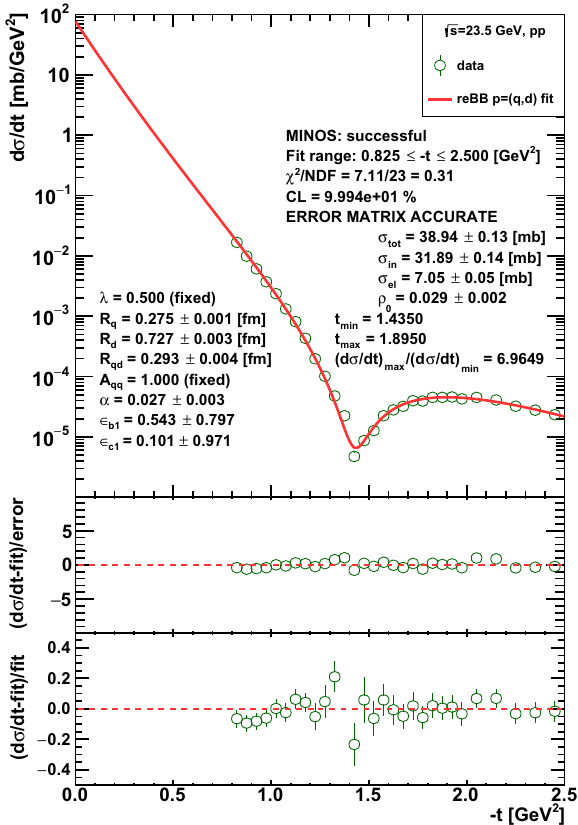
√ Fig. 29 The fit of the ReBB model to the pp ISR s = 23 . 5 GeV data in the range of 0 . 8 ≤ − t ≤ 2 . 5 GeV 2 [92]. The fit includes the t -dependent statistical (type A) and systematic (type B) uncertainties, the normalization (type C) uncertainty and the experimental values of the total cross section and parameter ρ 0 with their full error according to Eq. (6). The fitted parameters are shown in the left bottom corner and their values are rounded up to three decimal